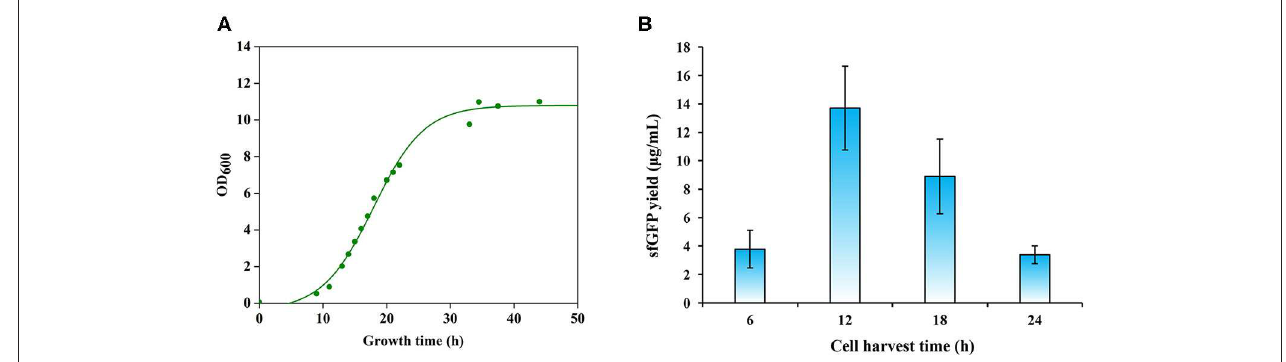
FIGURE 3 | Effects of cell growth phase on protein synthesis. (A) A representative growth curve of Pichia pastoris . (B) Comparison of sfGFP synthesis with cell extracts prepared from different growth phases. Values show means with error bars representing standard deviations (s.d.) of at least three independent